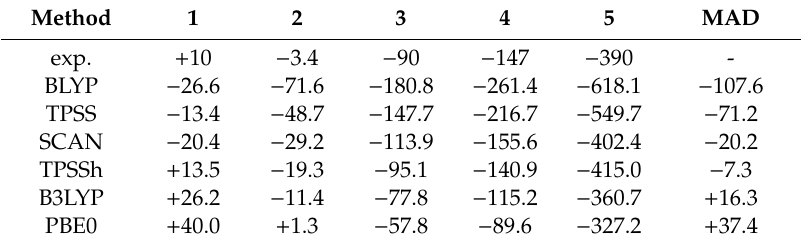
Table 2. Exchange coupling constants J (in cm − 1 ) computed with selected conventional density functionals for the five manganese complexes studied in this work, compared with experimentally fitted values. Mean absolute deviations (MAD) in cm − 1